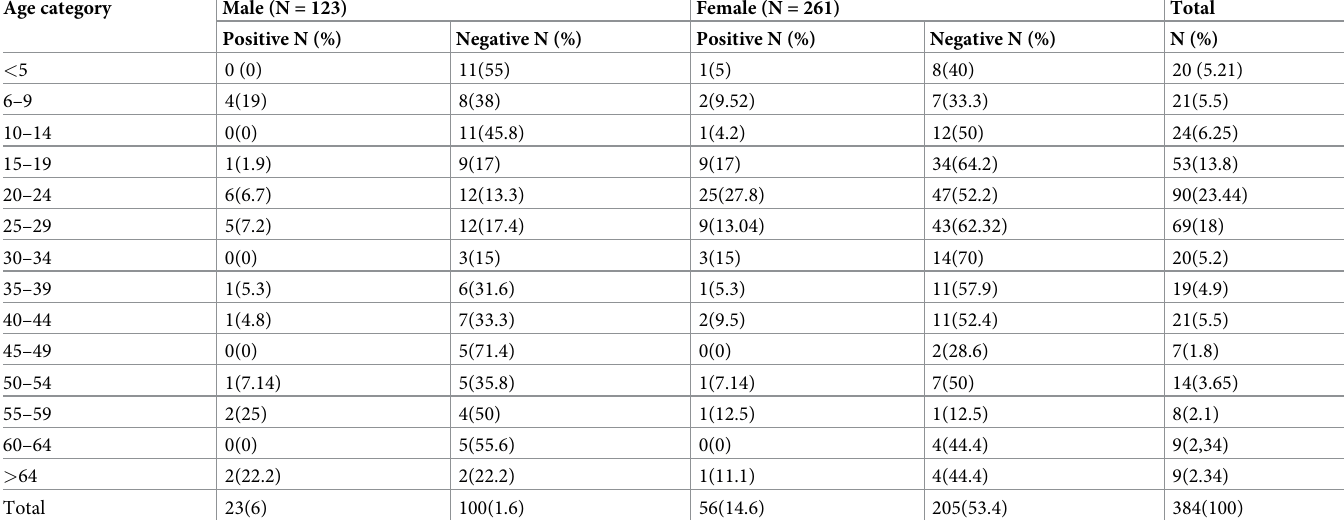
Table 2. Distribution of intestinal parasites prevalence respected to age and sex among patients requested for stool examination at Jimma health center, Southwest, Ethiopia (n = 384). Age category